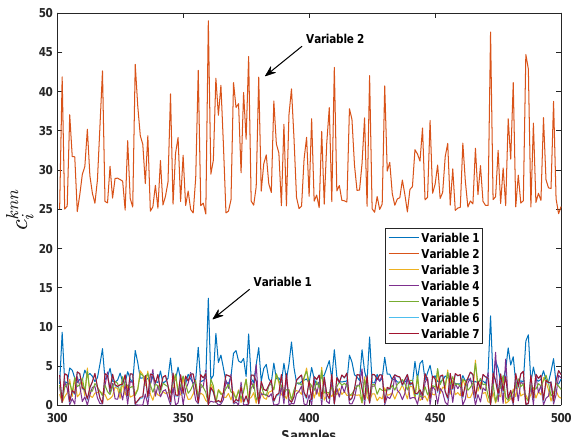
Figure 4. The variable contribution by kNN for case 1 of numerical simulation.